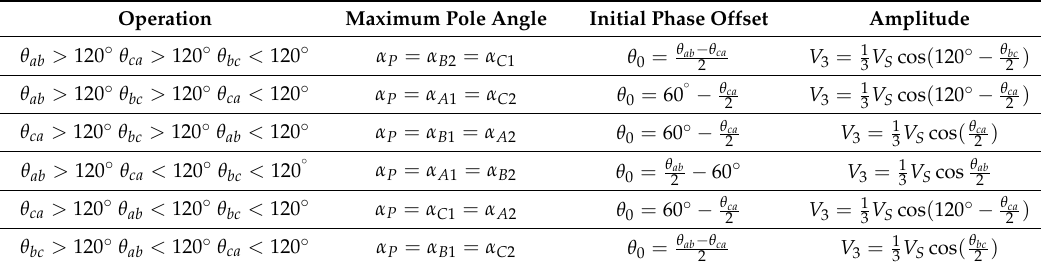
Table 1. Phase offset and amplitude of the injected third harmonic under different operation states.